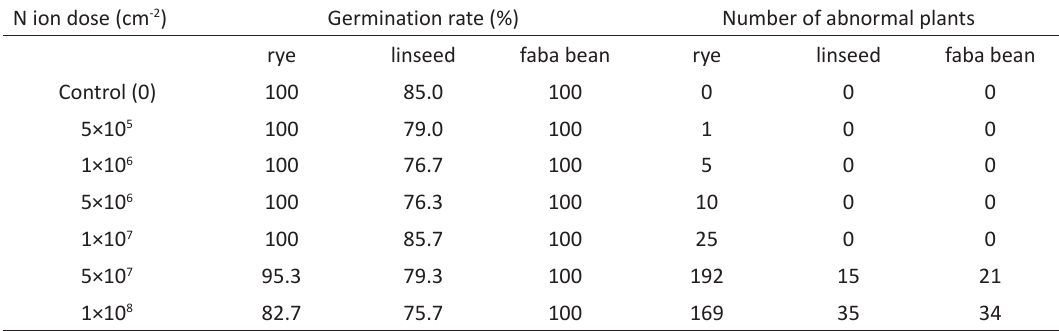
Table 1. Germination rate and frequencies of mutant plants at M1 on the three studied crop species N ion dose (cm -2 ) Germination rate